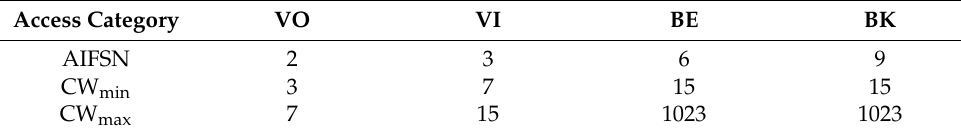
Table 1. Parameter value settings for access categories in IEEE 802.11p [4]. Access